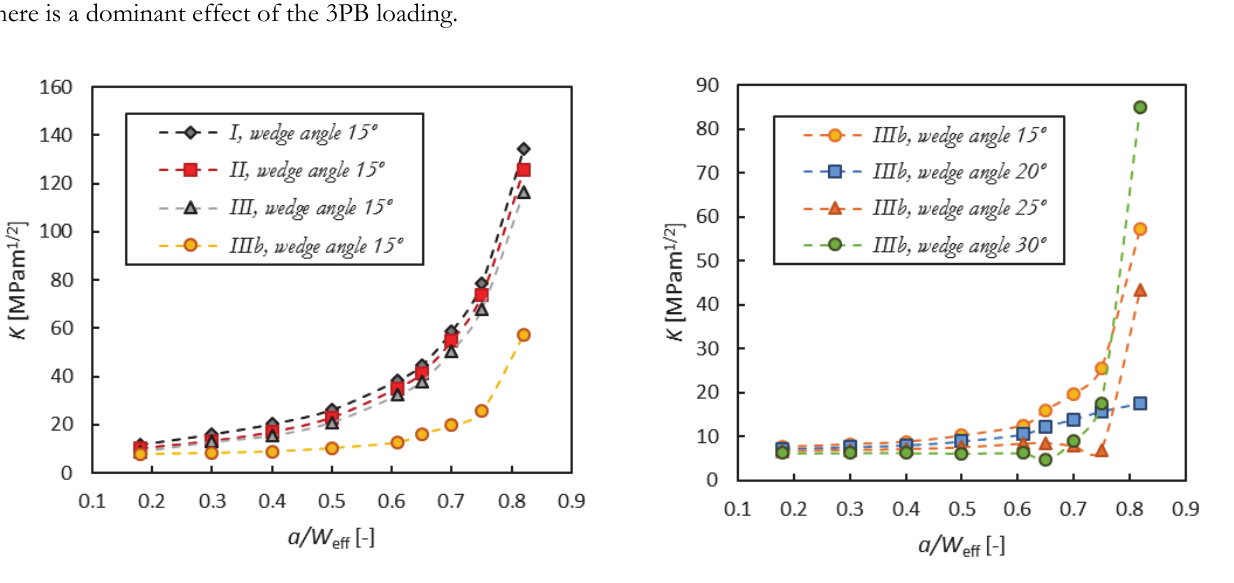
N UMERICAL R ESULTS